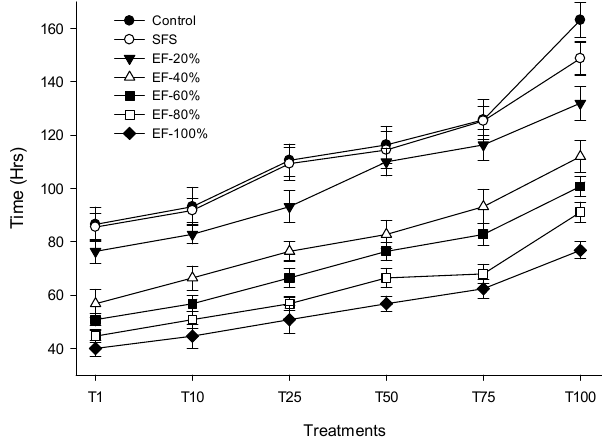
Figure 6. Effect of EF-LSEs on germination of tomato seeds—germination time course. Similarly, the rate of emergence of seeds increased, resulting in a decreased germination time